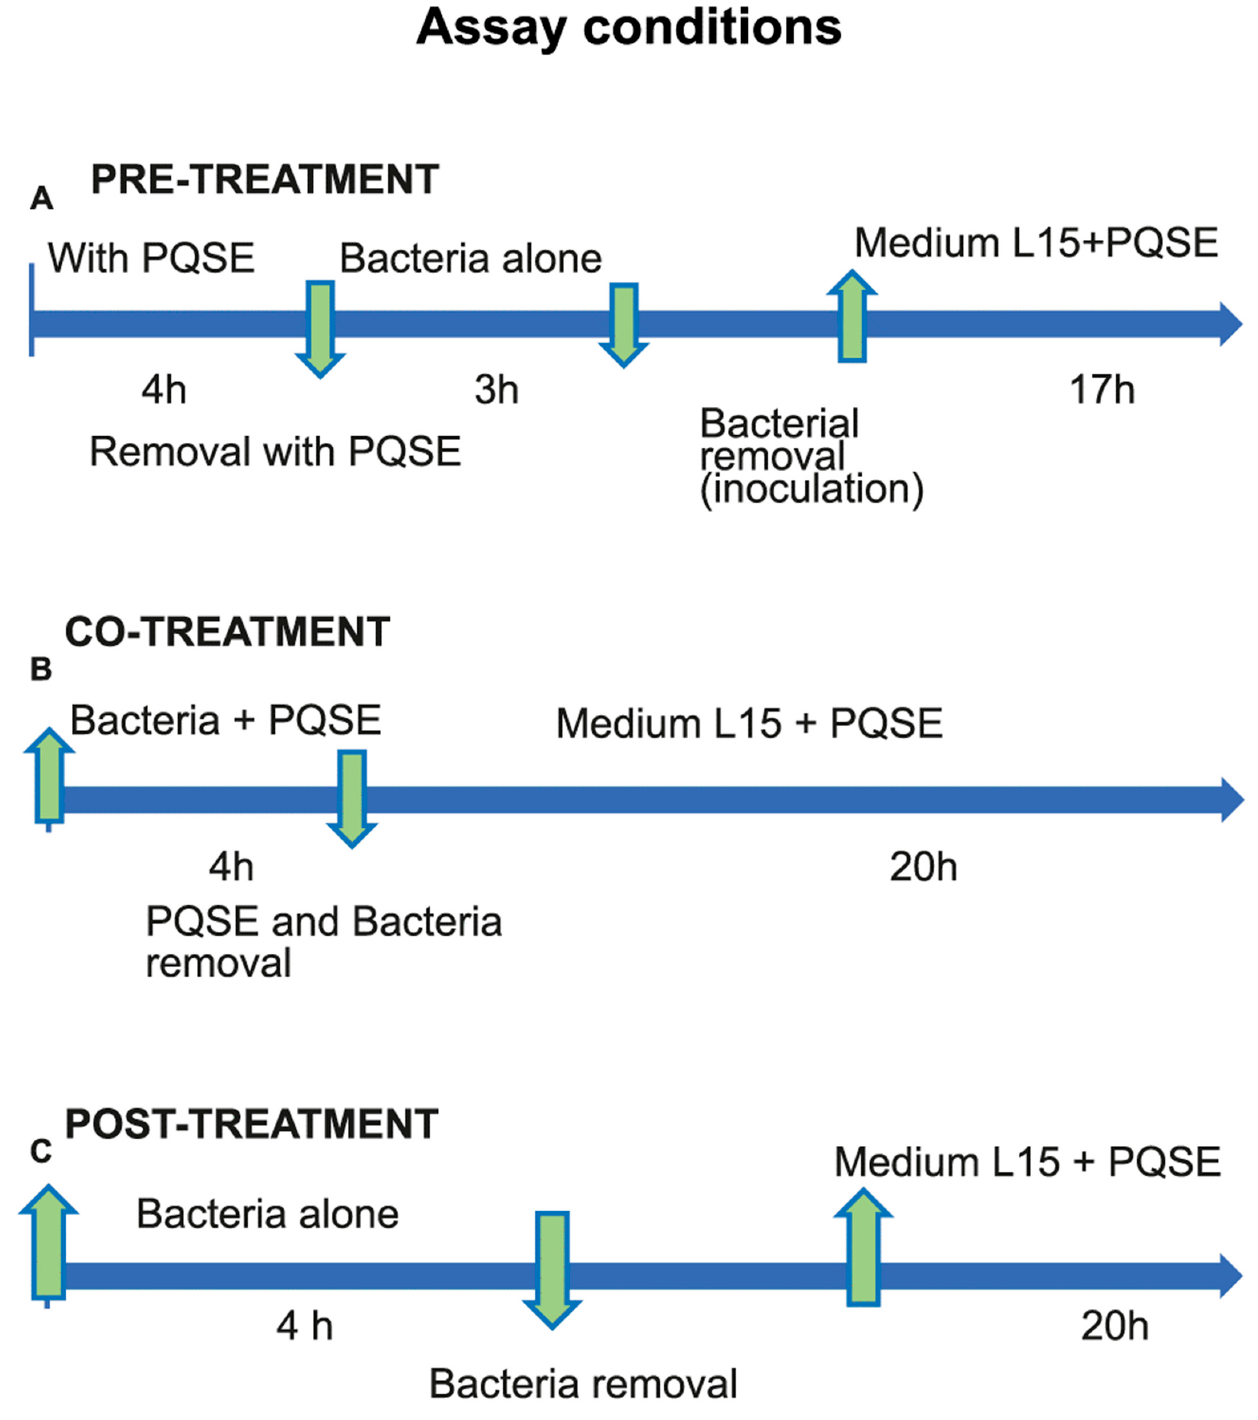
Figure 2. Assay conditions to phagosome-lysosome fusion measure. Three conditions, Pre-treatment, Co-treatment, and Post-treatment of SHK-1 cells with Quillaja Extract (PQSE), and challenged with P. salmonis, were used to evaluate the phagosome-lysosome fusion.